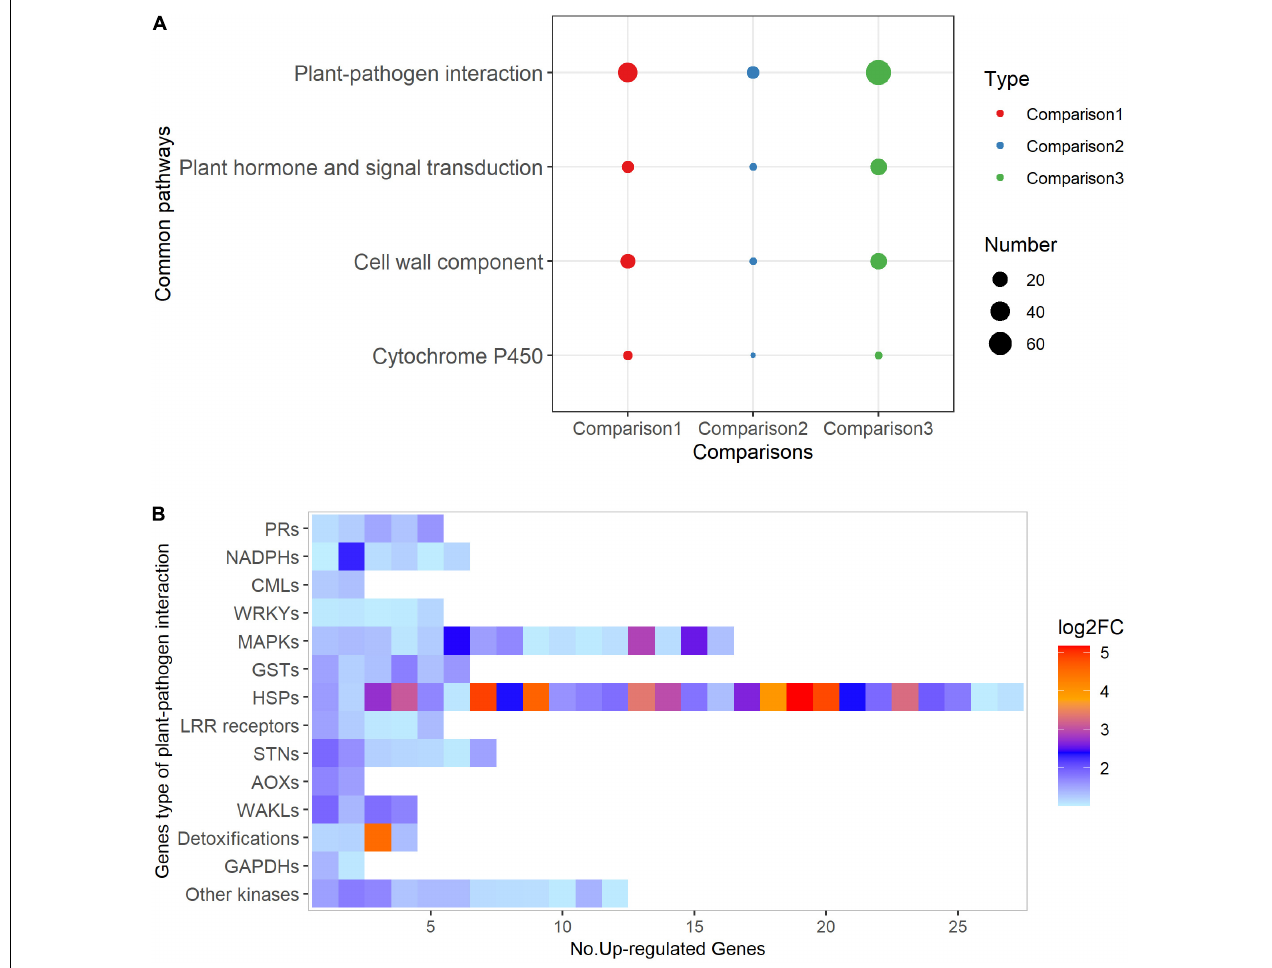
FIGURE 4 | Functional pathways analysis of up-regulated genes. (A) Common pathways identified in up-regulated genes in all three transcriptome comparisons. Comparison1, 48 DAS_ J2416K vs. J2416; Comparison2, 62 DAS_ J2416K vs. J2416; Comparison3, J2416K_ 62 DAS vs. 48 DAS. (B) Heatmap of 14 types of genes associated with the plant–pathogen interaction pathway. PRs, pathogenesis-related genes; NADHs, NADPH oxidases; CMLs, CaM-like proteins; WRKYs, WRKY transcription factors; MAPKs, mitogen-activated protein kinases; GSTs, glutathione transferases; HSPs, heat shock proteins; STNs, serine/threonine protein kinases; AOXs, alternative oxidases; WAKLs, wall-associated receptor kinases; GAPDHs, glyceraldehyde-3-phosphate